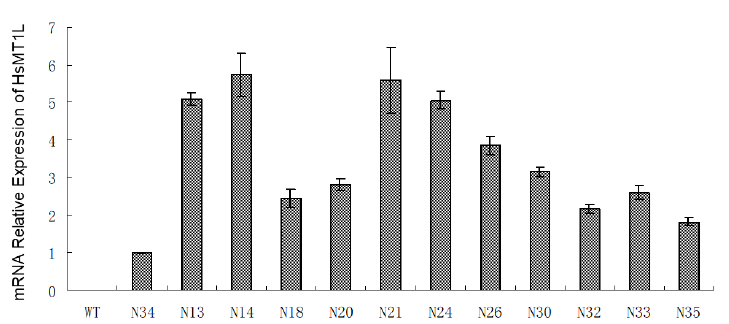
Figure 1. HsMT1L transcript levels among different lines. WT: wild-type tobacco; N13~N35: HsMT1L transgenic lines.